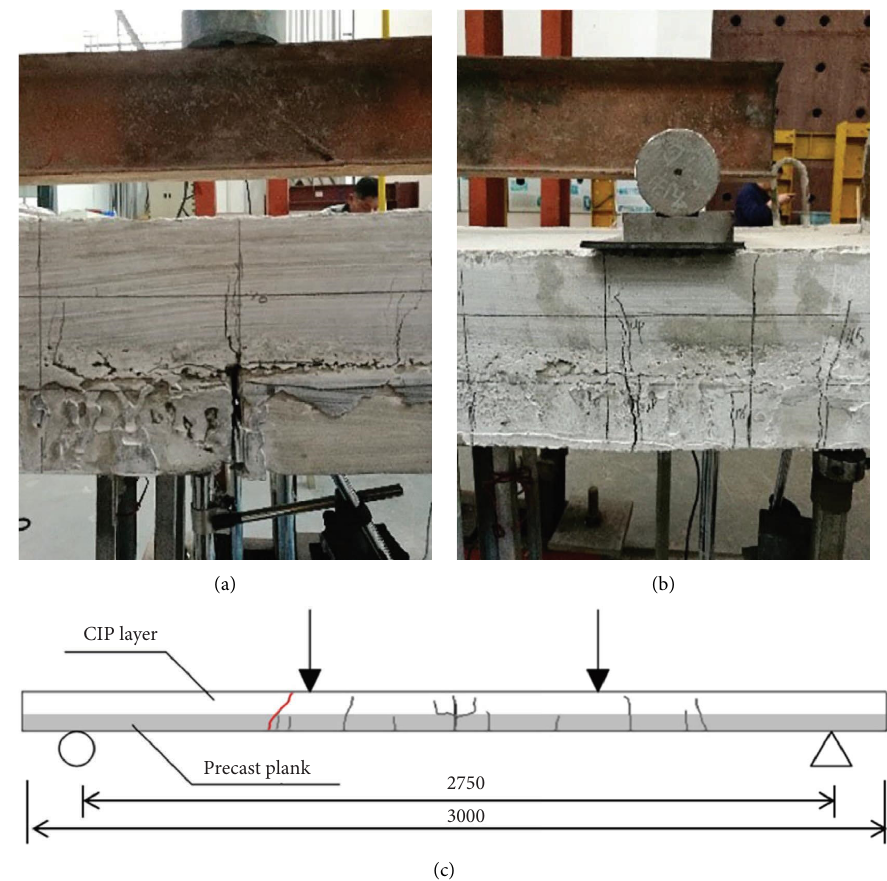
Figure 11: Failure phenomenon of LGSB3. (a) Cracking at midspan. (b) Cracking in the precast plank. (c) Crack